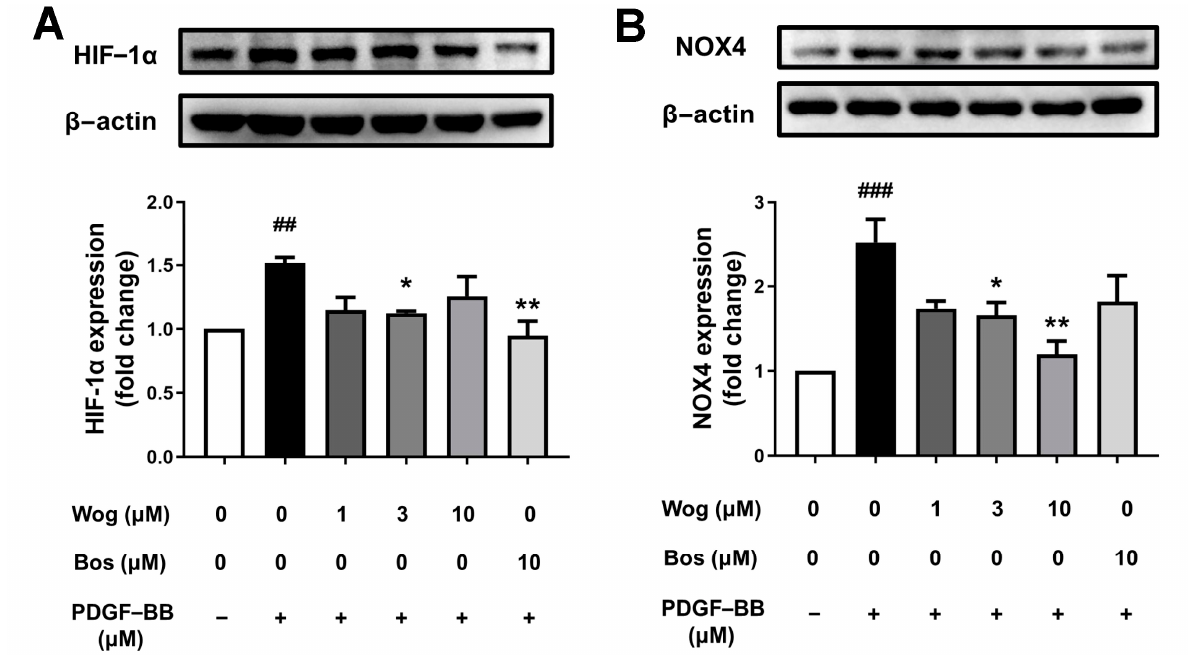
Figure 9. Effects of wogonin on HIF-1/NOX4 pathway. Effect of wogonin on HIF-1 α ( A ) and NOX4 ( B ) expression in PASMCs by Western blot analysis. Results are presented as mean ± SEM (n = 3–4). ### p < 0.001, ## p < 0.01 vs. control group, * p < 0.05, ** p < 0.01vs. model group.